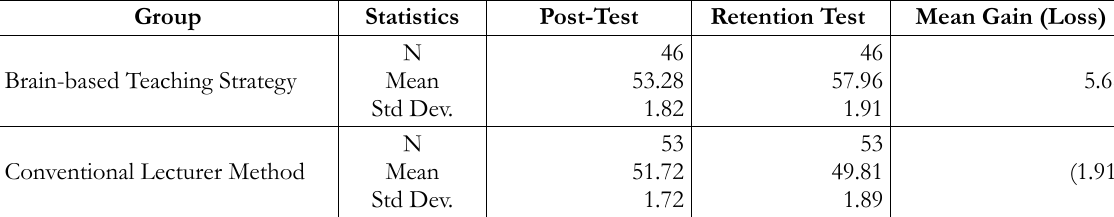
Table 4. Effect of brain-based teaching strategy on retention